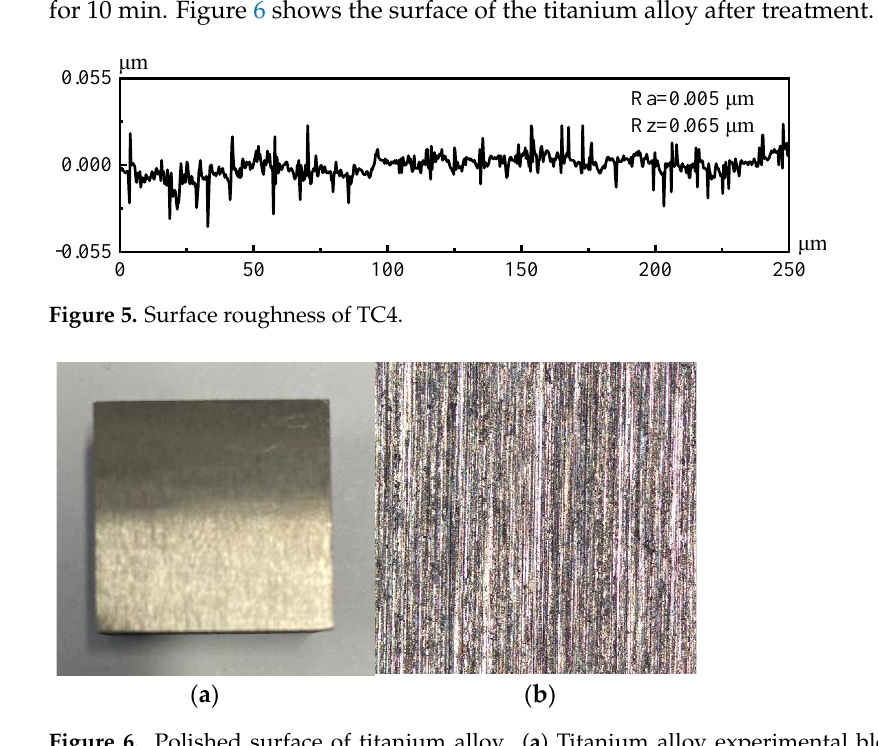
Figure 6. Polished surface of titanium alloy. ( a ) Titanium alloy experimental block ( b ) Surface morphology of the sample after pre-treatment ( 500 μm ) .